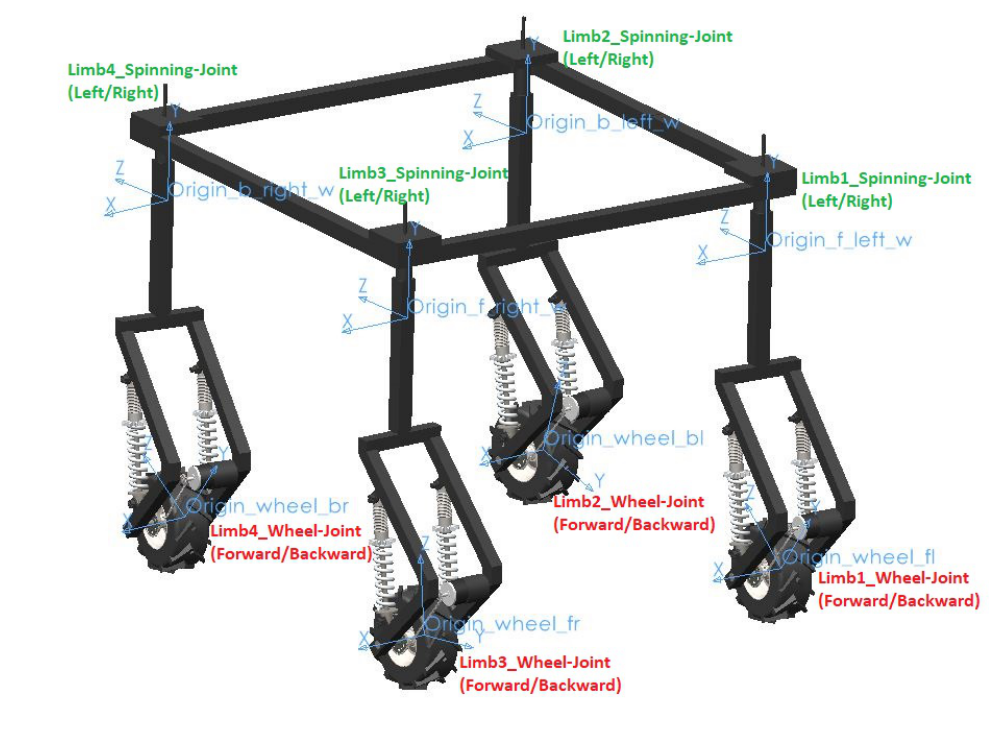
Figure 1. Three-dimensional structure of the weed-killing robot designed in SolidWorks with steering and translational joints (green and